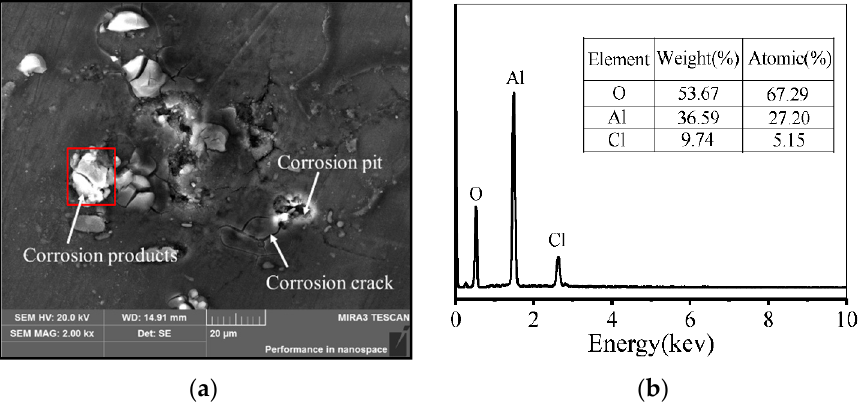
Figure 6. Corrosion morphology and corrosion products: ( a ) SEM observation; ( b ) EDS of corro- sion products.